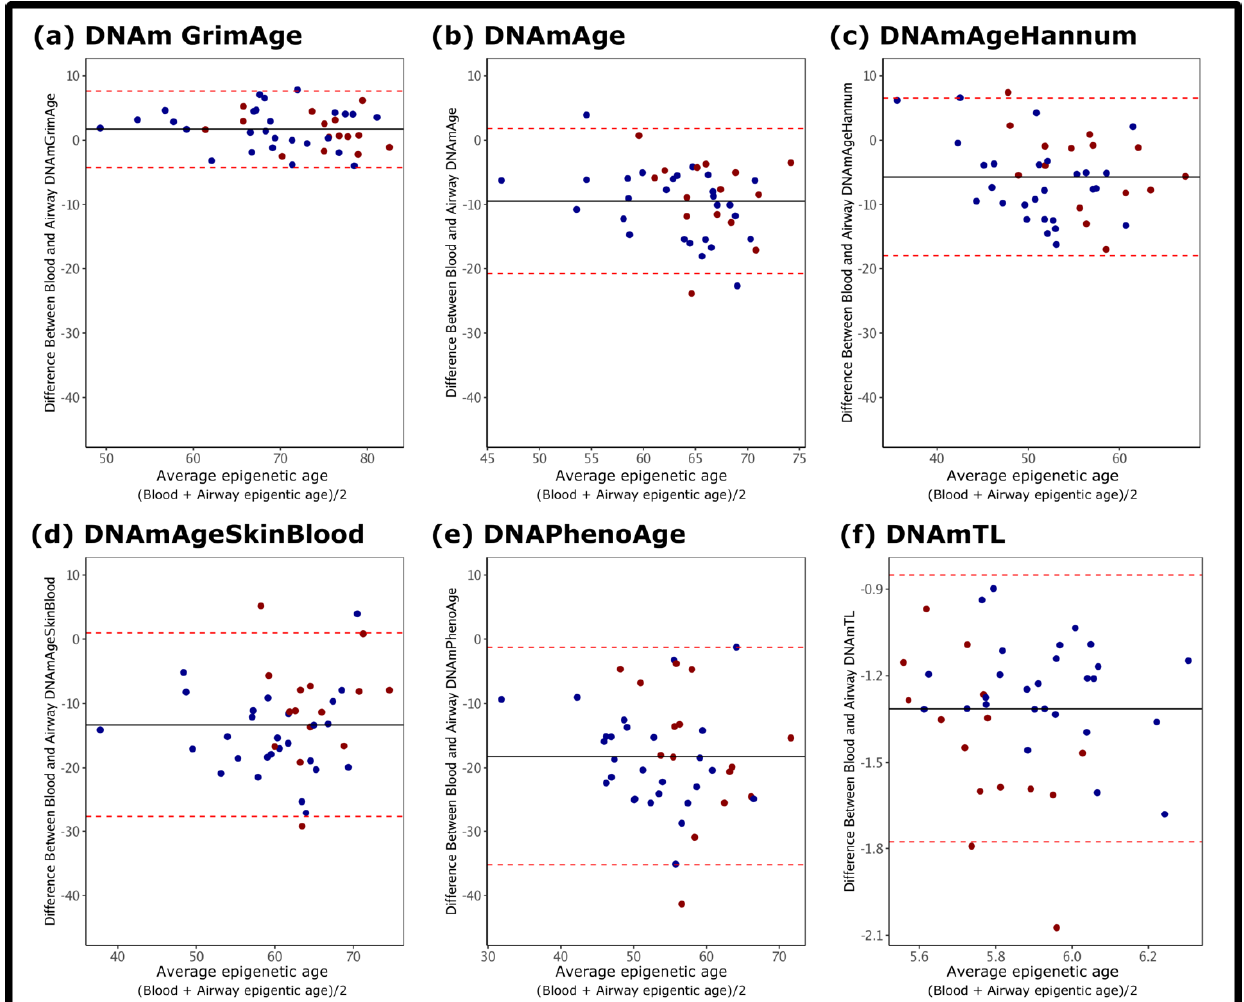
Figure 1. Difference between airway epithelial and blood epigenetic age. Bland–Altman Plots show the difference between the measurements ( y -axis) and average values for the blood and airway epigenetic age ( x -axis) for: ( a ) DNAmGrimAge; ( b ) DNAmAge (pan-tissue); ( c ) DNAmAgeHannum; ( d ) DNAmAgeSkinBlood; ( e ) DNAmPhenoAge; ( f ) DNAmTL. Blue dots: non-COPD. Red dots: COPD. Red dotted lines: standard deviation. Black horizontal line: average difference between blood and airway epigenetic age.